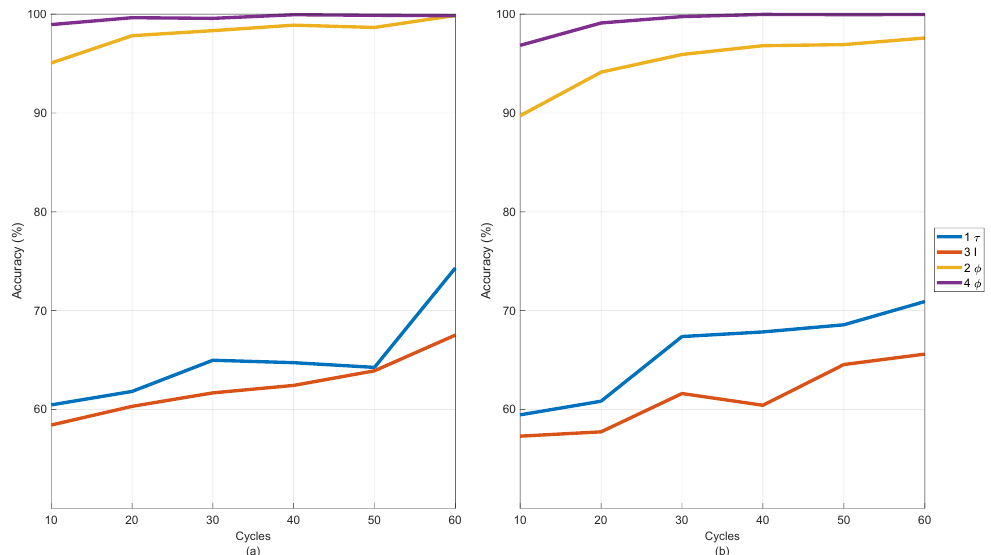
Figure 15. Performance of FNN-classifier for detecting local demagnetisation alone with spectrograms computed from different numbers of cycles in operations of ( a ) Profile 2 and ( b ) Profile